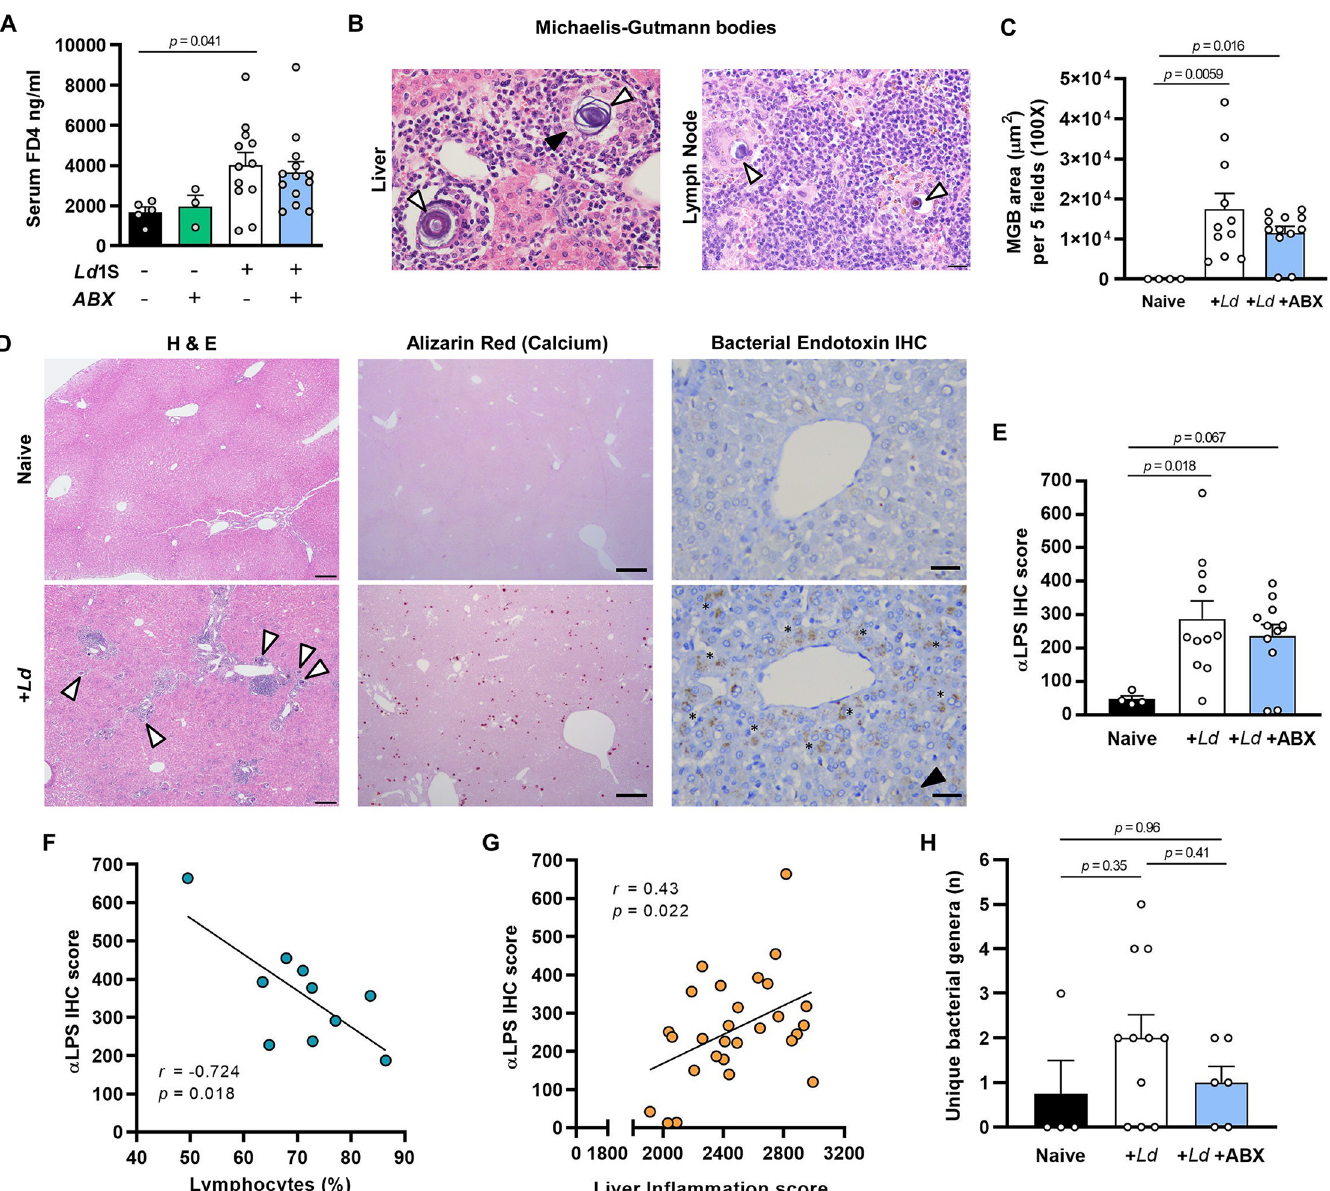
Fig 9. Evidence of bacterial co-infection in hamster visceral leishmaniasis. (A) Na ï ve or L . donovani ( Ld ) infected hamsters maintained on drinking water with or without antibiotic cocktail (ABX) were fed fluorescently-labelled 4 kDa dextran at 12 weeks post-infection (wpi). After 4 hours the intensity of fluorescence in serum samples was measured as an indicator of intestinal barrier leakiness. (B) Histological sections stained with haematoxylin and eosin showing presence of Michaelis- Gutmann bodies (MGBs, white arrows) in L . donovani infected liver and duodenal lymph node tissue, black arrow indicates intracellular amastigotes. (C) Quantification of MGB abundance at 12 wpi. (D) Histological liver sections stained with haematoxylin and eosin (left), alizarin red for calcium detection (centre) and immunohistochemical (IHC) detection of bacterial endotoxin (right), white arrows indicated MGBs, black arrow indicates intracellular amastigotes, asterisks indicate anti-endotoxin IgG-reactive areas. Image magnifications and scale bars are 400X and 20 μ m (C), 12.5X and 1 mm (D, H&E, upper), 40X and 200 μ m (D, H&E, upper) 100X and 500 μ m (alizarin), 400X and 30 μ m (IHC). (E) Quantification of anti-endotoxin IgG-reactive areas at 12 wpi. (F,G) Pairwise comparison and Pearson correlation tests of liver endotoxin content and peripheral blood lymphocyte frequency (F, n = 10) and liver inflammation scores (G, n = 28). (H) Quantification of unique bacterial genera present in liver tissue assessed by 16S rDNA sequencing. Data are for male hamsters. Data on charts (A,C,E,H) are means +SEM, compared by one-way ANOVA, n =